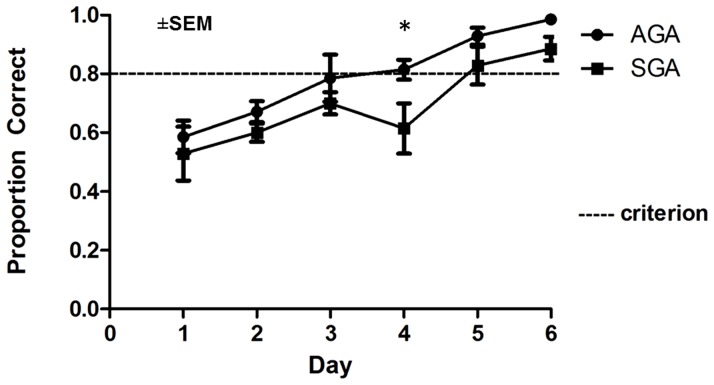
Performance of AGA and SGA piglets during the acquisition phase of a spatial T-maze task.Performance of AGA and SGA piglets improved over time (p<0.001) but AGA piglets reached criterion 2 d sooner than SGA piglets. The asterisk indicates performance of SGA piglets was lower on d 4 compared to AGA piglets (p = 0.01). Data are shown as the mean ± SEM (n = 7).